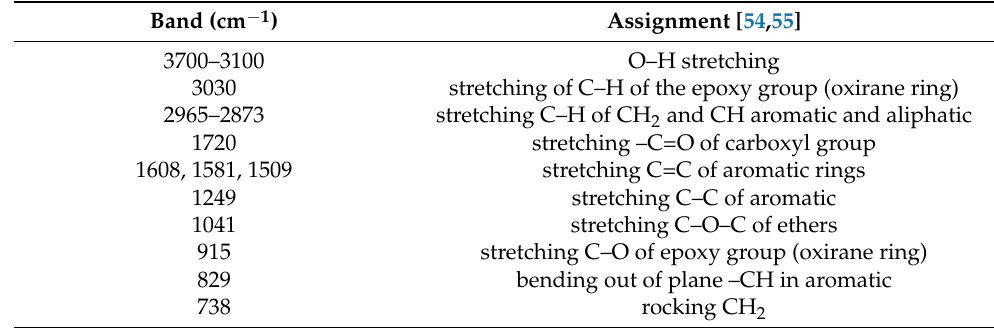
Table 1. Characteristic bands of epoxy resin (ER) in the IR